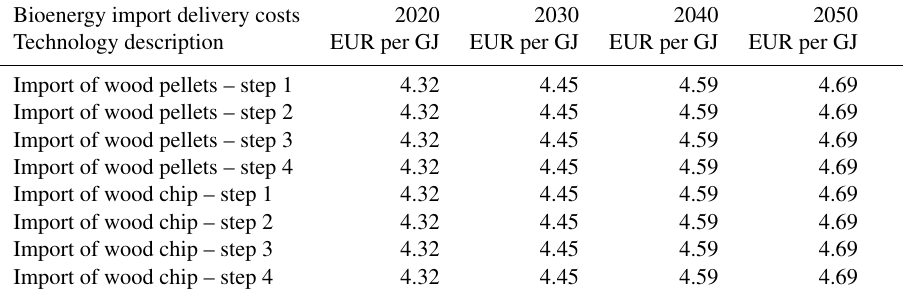
Table A3. Import bioenergy delivery costs.